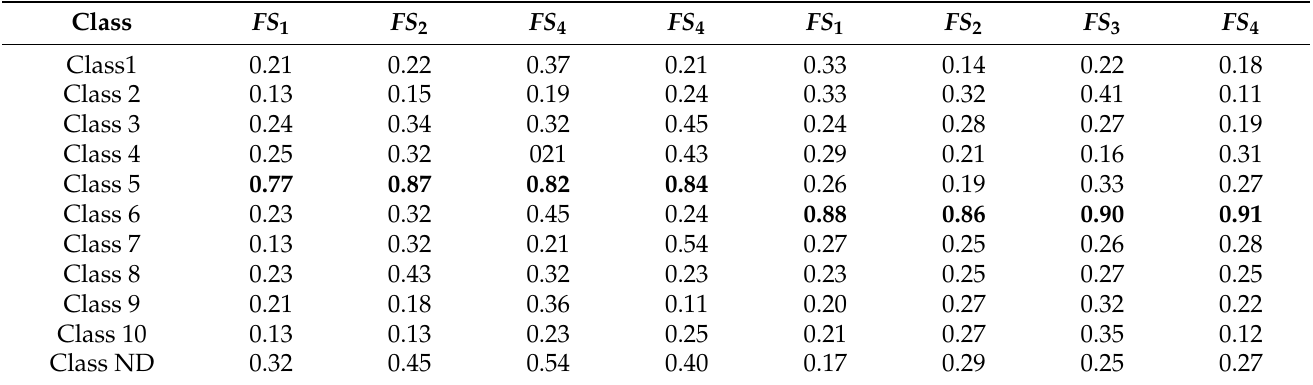
Table 7. FS 1 , FS 2 , FS 3 and FS 4 values obtained by comparing the EC maps of classes 5 and 6 with the remaining classes (the values highlighted in bold refer to the best